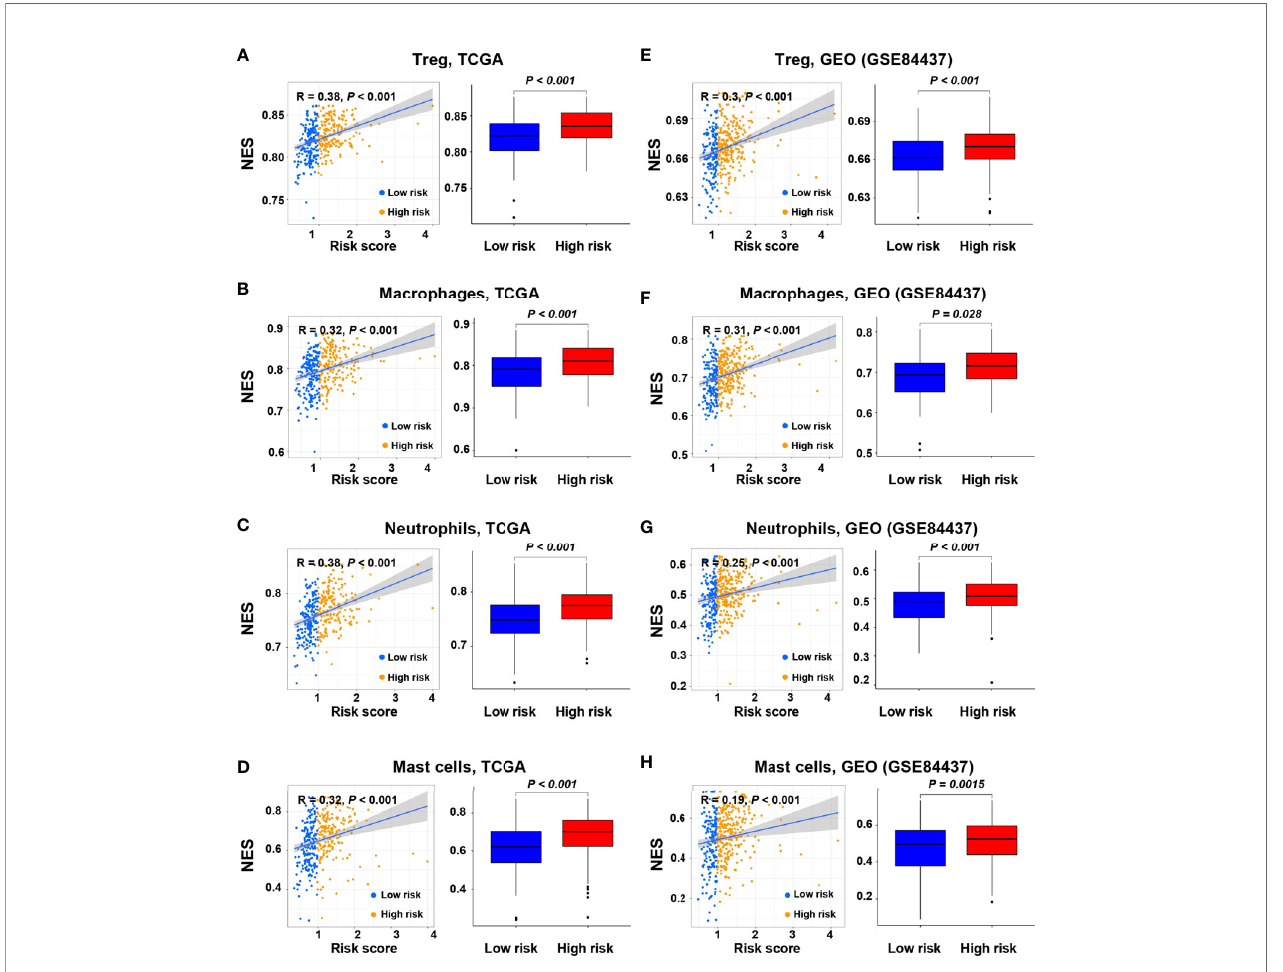
FIGURE 4 | Correlation of the risk score with immune cell subtypes in the screening and validation cohorts. (A, E) Regulatory T cells; (B, F) Macrophages; (C, G) Neutrophils; (D, H) Mast